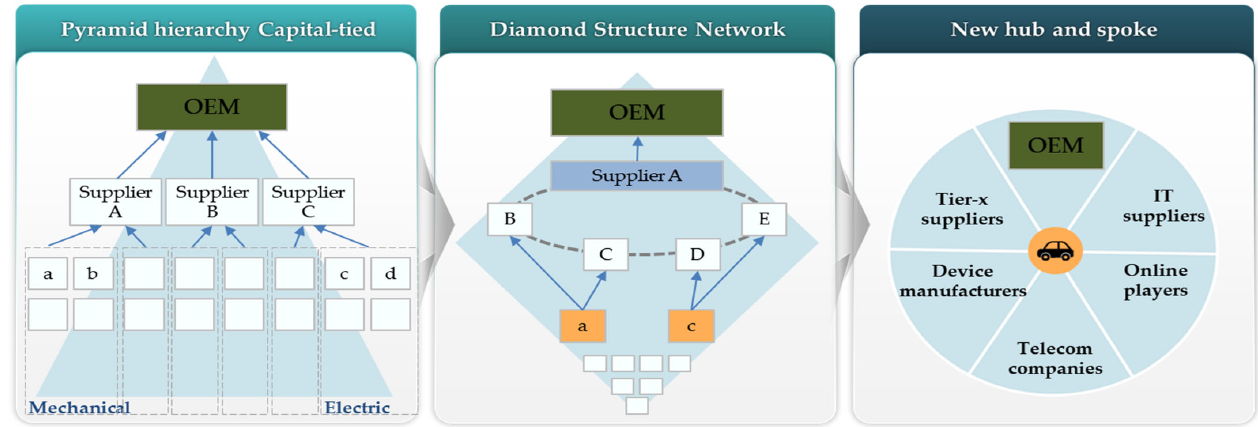
Figure 5. Changes in the automotive industry structure [25,26].